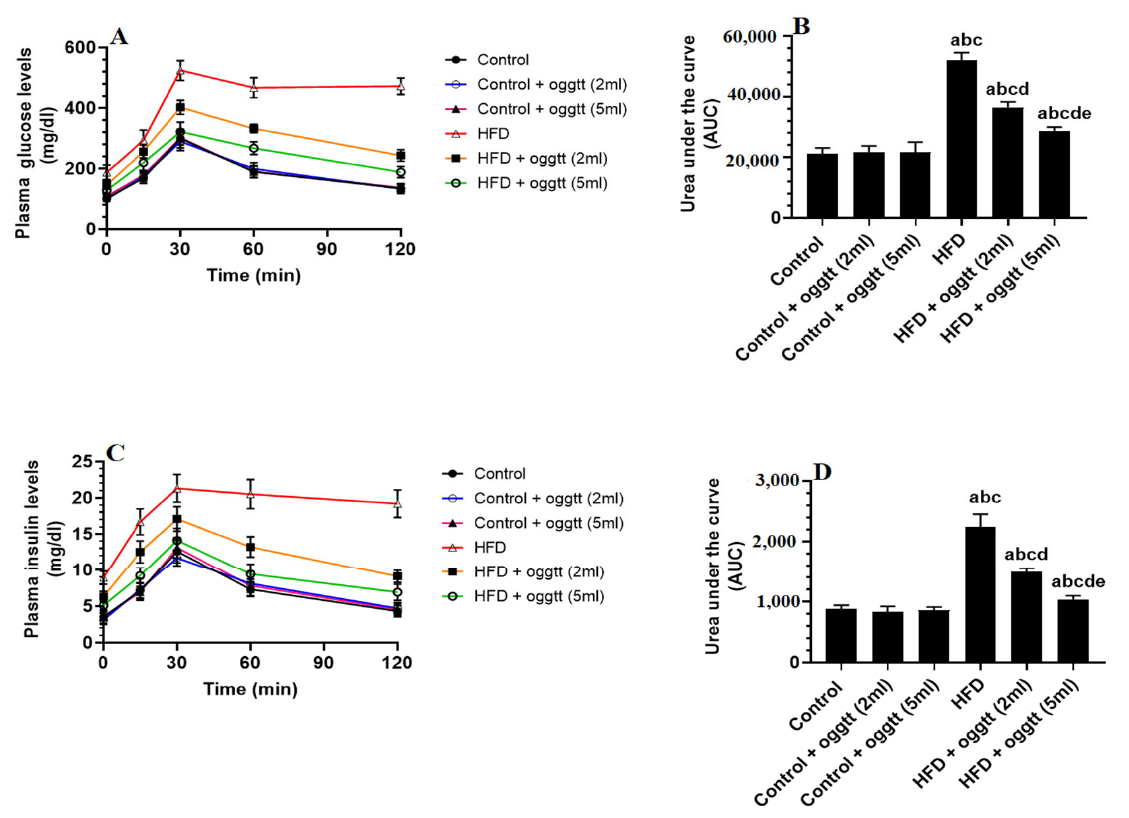
Figure 2. Oggtt milk attenuates the impairment in oral glucose tolerance test in the high ‐ fat diet (HFD) ‐ fed rats in a dose ‐ dependent manner. ( A , B ) Plasma glucose levels and the corresponding area under the curve (UAC) as measured at 0.0., 15, 30, 60, and 120 min in all groups of rats post glucose administration. ( C , D ) Plasma insulin levels measured at the same time intervals measured post glucose administration in the same groups of rats. Data were expressed as means ± SD for n = 8 rats/group. a, vs. control; b, vs. control + oggtt (2 mL); c, vs. control + oggtt (5 mL); d, vs. HFD; and e, vs. HFD + oggt (2